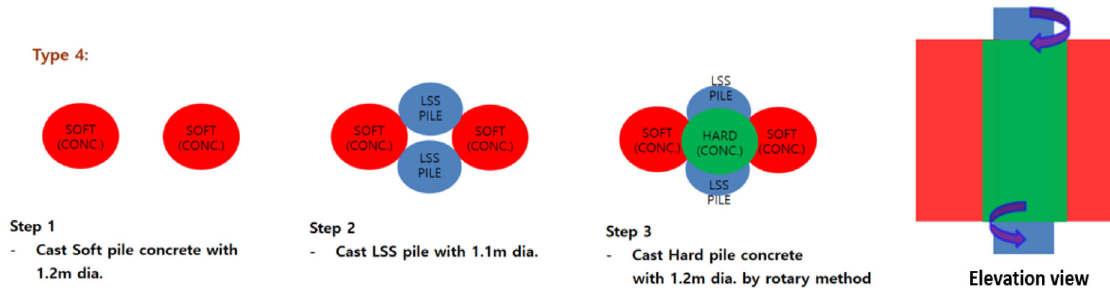
Fig. 10 Method for construction of type 4 SBPs (plan and elevation)